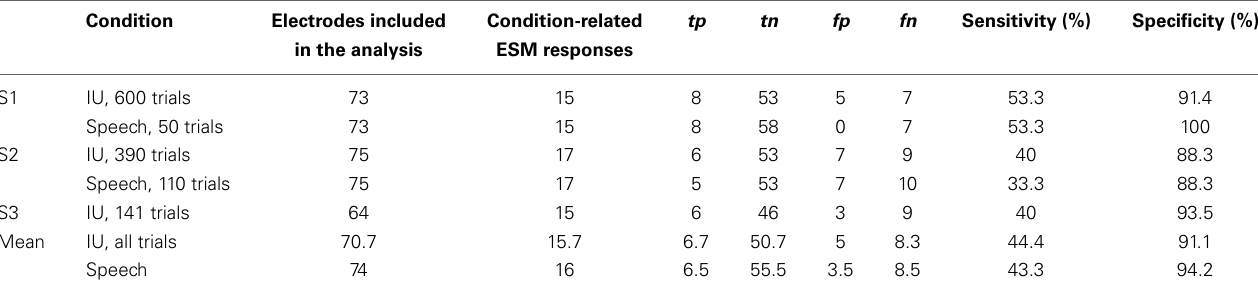
Table 4 | Comparison of HGM of mouth motor and language functions for IUs and speech onset-related high gamma